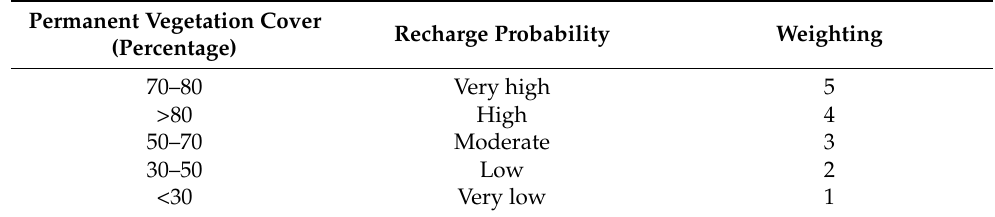
Table 2. Adjusted weighting and probability of groundwater recharge according to the percentage of permanent vegetation